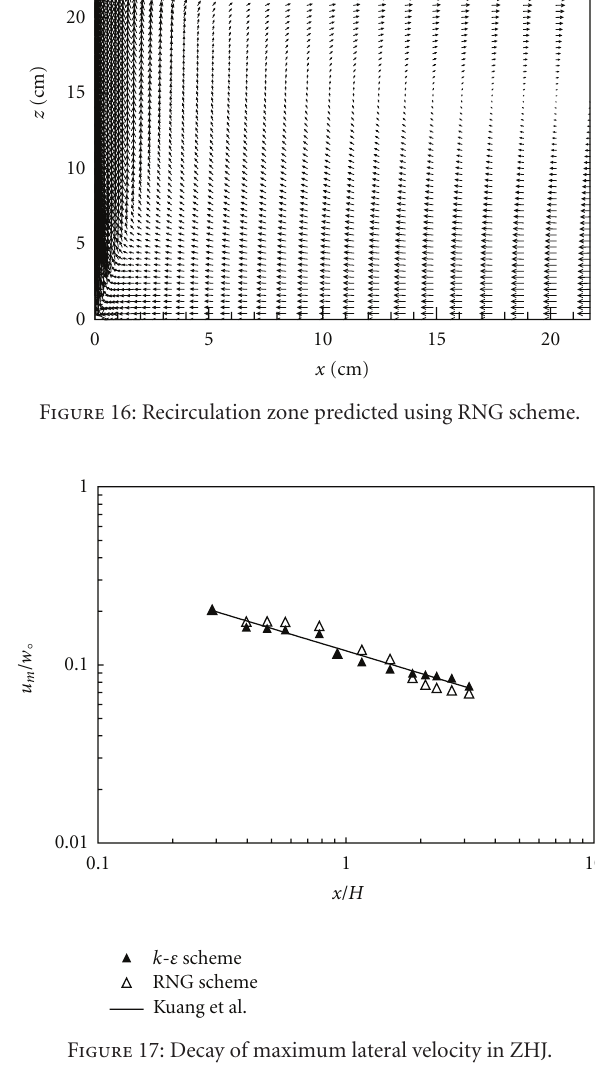
Figure 15: Profiles of lateral velocity in ZHJ (RNG scheme).